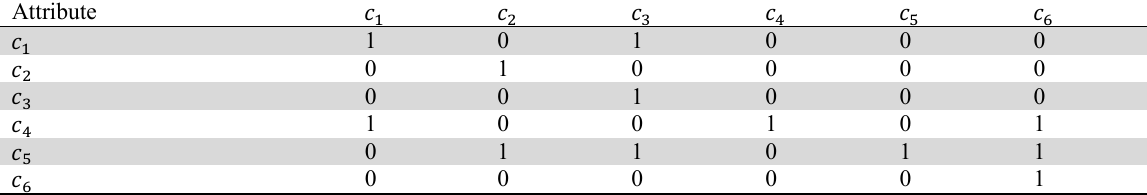
Initial reachability matrix for supplier evaluation problem